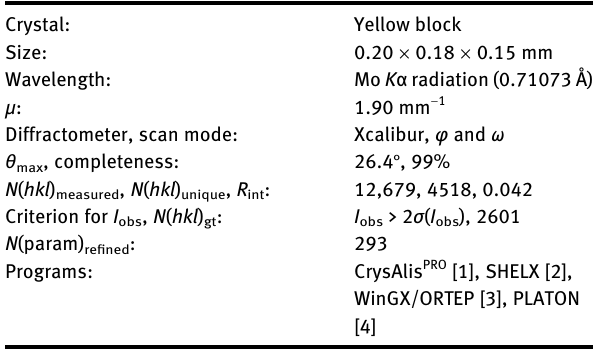
Table  : Data collection and